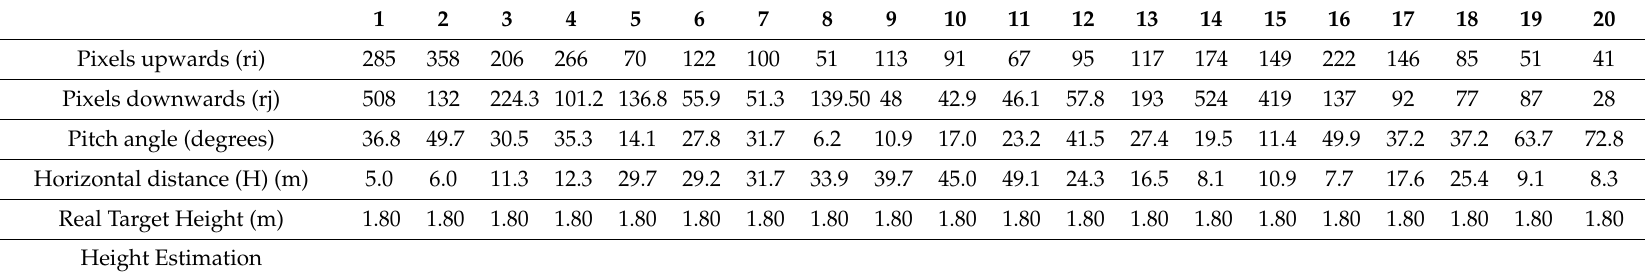
Pixels downwards (rj)